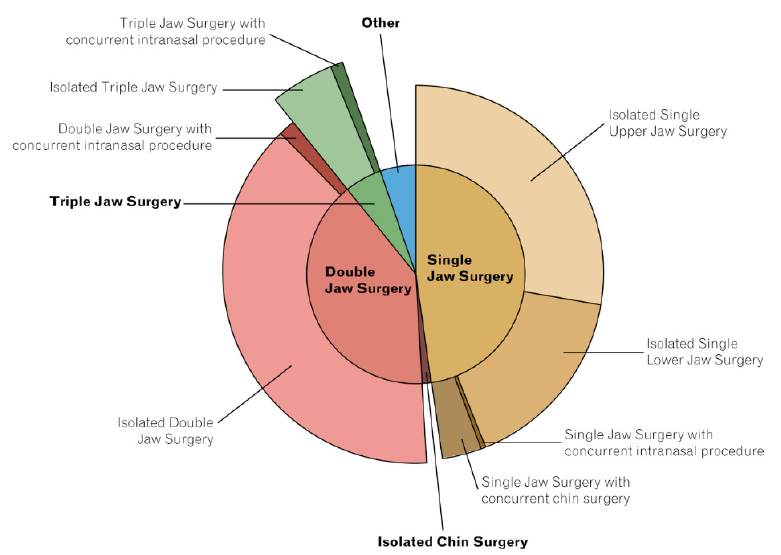
Figure 1. Procedure distribution. The majority of patients underwent single jaw surgery (47.8%), followed by double jaw surgery (40.1%). Other procedures, which constituted 5.3% of all procedures included, for example, unspecified osteoplasties and combined genioplasty plus intranasal proce- dures.